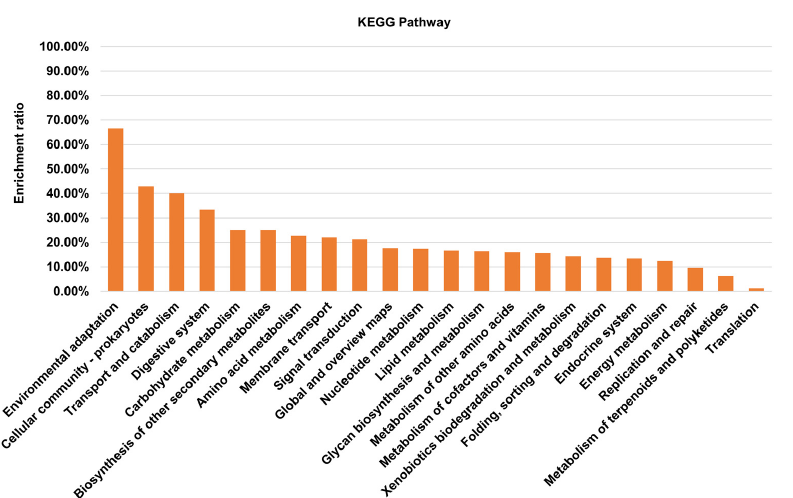
Figure 2. The KEGG pathway enrichment of the 417 Tn917-inserted genes. The 417 genes were assigned with a K number by using the BlastKOALA tool. The K number was then used to map each gene to its corresponding KEGG pathway using the Reconstruct tool of the KEGG mapper. The enrichment ratio indicates the number of genes identified from the Tn mutant library in each KEGG pathway to the number of total genes included in the S. suis SC19 genome in this pathway.